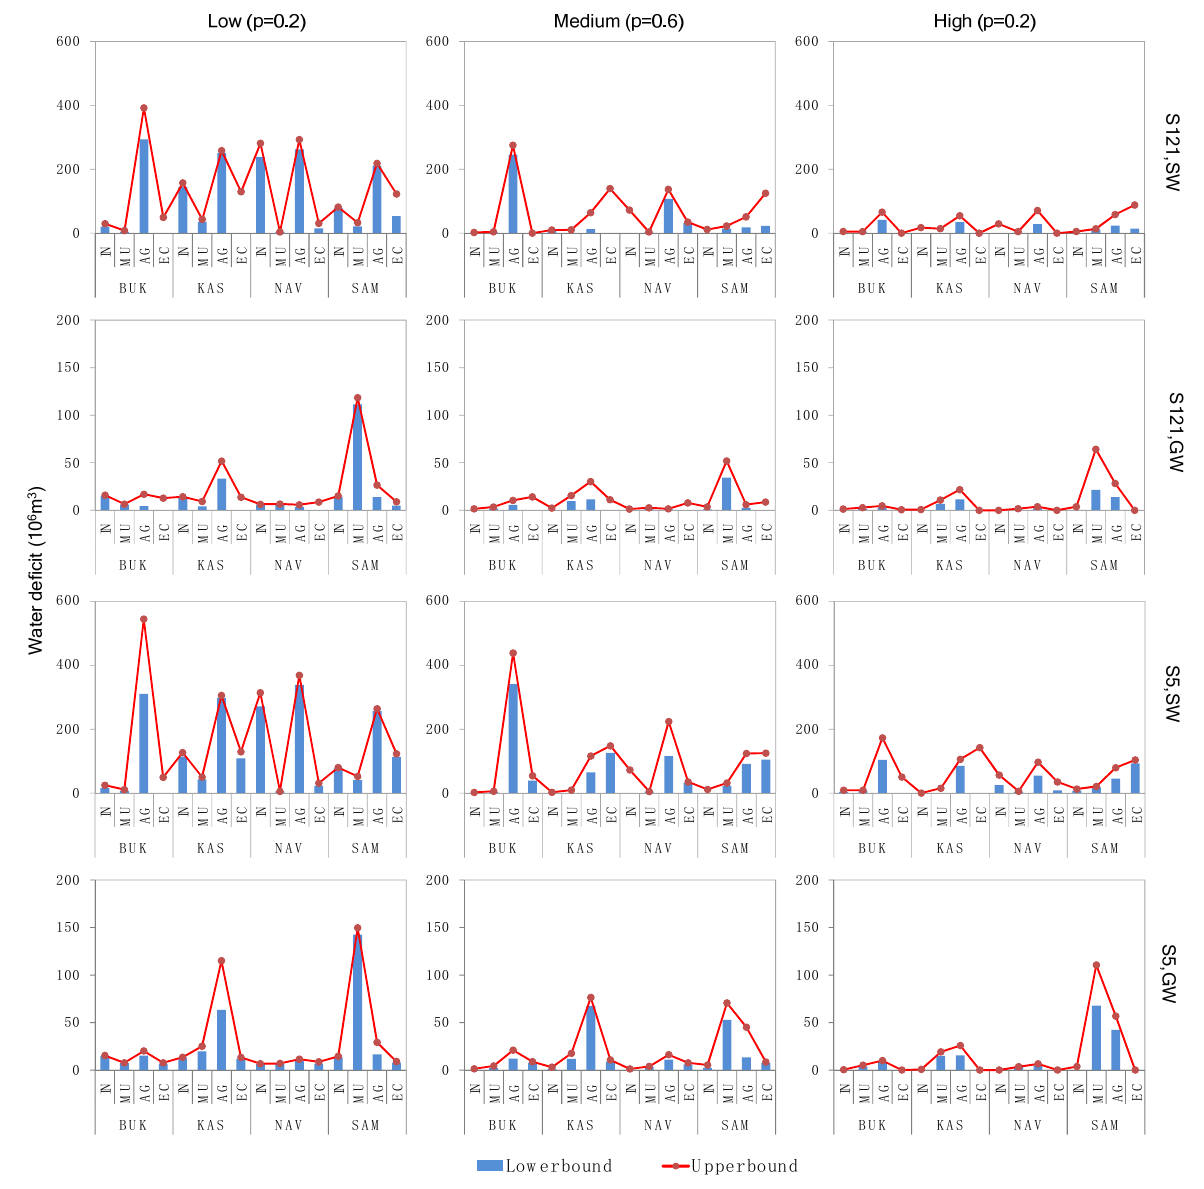
Figure 5. The water deficits of water users in different scenarios. Figure 6 depicts the solutions of the optimized water-resource allocation scheme for water users in different scenarios (high-benefit (S121) and low-benefit (S5) scenarios) obtained from the HFOP-SGW model. The results show that the water-resource allocation patterns are closely related to the regional water-use structure and economic policy. In detail, agricultural users are in the highest position to be adjusted for water demand when water security and emergency development need to be guaranteed. For instance, at a low-flow level, the water supply of surface water for agriculture in Bukhara is [924, 1023] × 10 6 m 3 , in S121; at a high-flow level, the value would be [1250, 1275] × 10 6 m 3 . This is because irrigated agriculture possesses high water requirements and low economic benefits. Different water-supply schemes are generated according to the water-resource demands of water users. The results show that in various scenarios, the demand for municipal water mainly comes from groundwater. Under different inflow levels, municipal water is most sensitive to groundwater availability. The main reason for this is the high salinity of surface water in Central